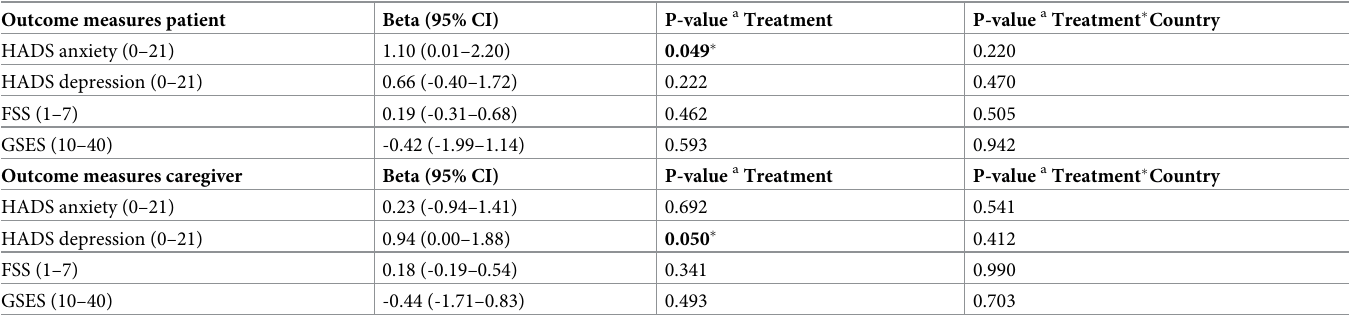
Table 2. Secondary treatment effects and study setting interaction